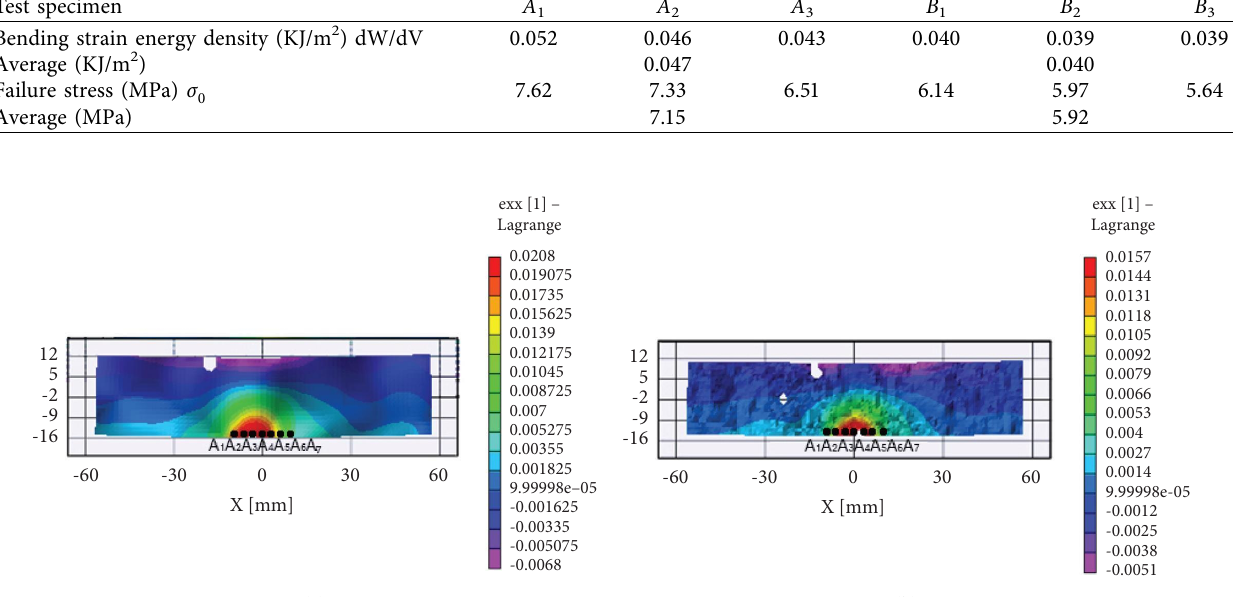
Figure 8: Horizontal strain feld diagram of nonlinear damage stage: (a) horizontal strain feld diagram of A (b) horizontal strain feld diagram of B 3 point from Figure 7.